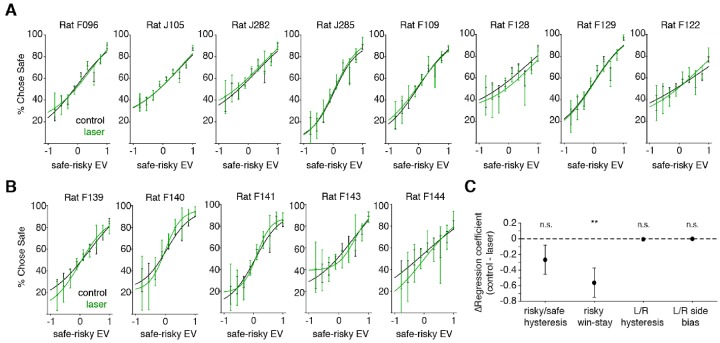
Photoinhibition during the choice reporting period does not affect baseline performance, but selectively reduces the risky win–stay bias.(A) Psychometric performance for each CaMKIIα-eNpHR3.0 rat on control trials (black) and trials following photoinhibition during the choice period. These plots include all trials, regardless of trial history, so the elimination of the risky win-stay bias is not evident. (B) Psychometric performance for each Pvalb-iCre-ChR2 rat on control trials (black) and trials following photoinhibition during the choice period. (C) Difference in logistic regression coefficients (control - photoinhibition) parameterizing different choice biases. Data are mean ± standard deviation across rats. Asterisks indicate significant Bonferroni-corrected p-value from one-way ANOVA (p=0.0063).